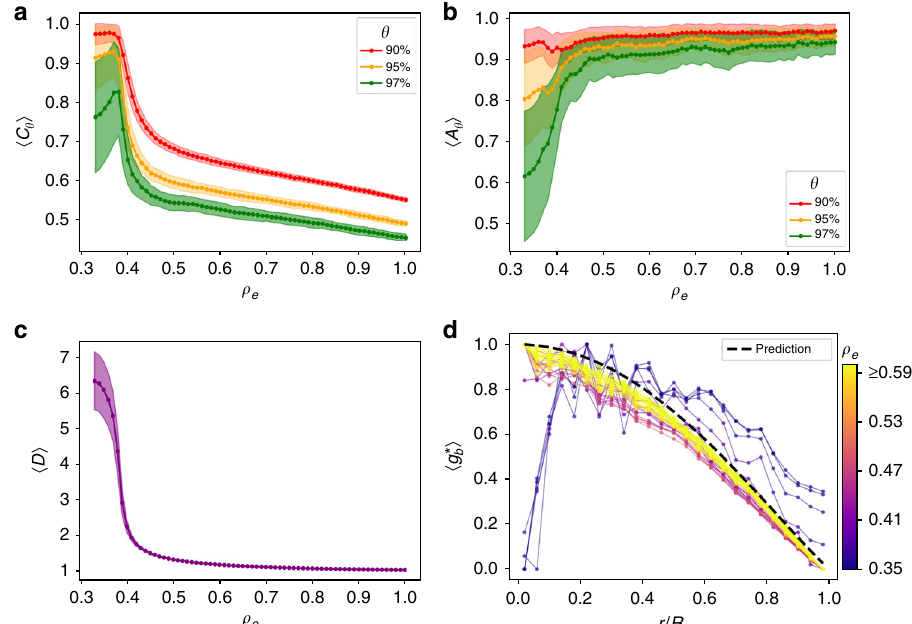
Fig. 4 Quantifying the spatial effect of edge-density ρ e on high betweenness nodes a The metric 〈 C θ 〉 (Eq. (9)) decreases for denser networks, capturing the tendency of the nodes to be increasingly clustered around their center of mass. b Correspondingly they also become more isotropic around this center as A θ (Eq. (11)) approaches 1. c The network also becomes increasingly geometric as indicated by the decrease in the average detour factor measured for the full network, which experiences an abrupt transition around ρ e ∼ 0.4. The shaded regions represent fl uctuations over hundred realizations of the randomization procedure. d The average BC for nodes at a distance r from the barycenter (rescaled to the interval [0,1]), measured in units of r / R where R = 50 is the grid boundary. Curves are colored according to the value of ρ e . The dashed line corresponds to the analytical calculation for an in fi nitely dense random geometric graph 55 . The metrics are computed for the networks generated in Fig. 3. (here h ¼ i indicates averaging over